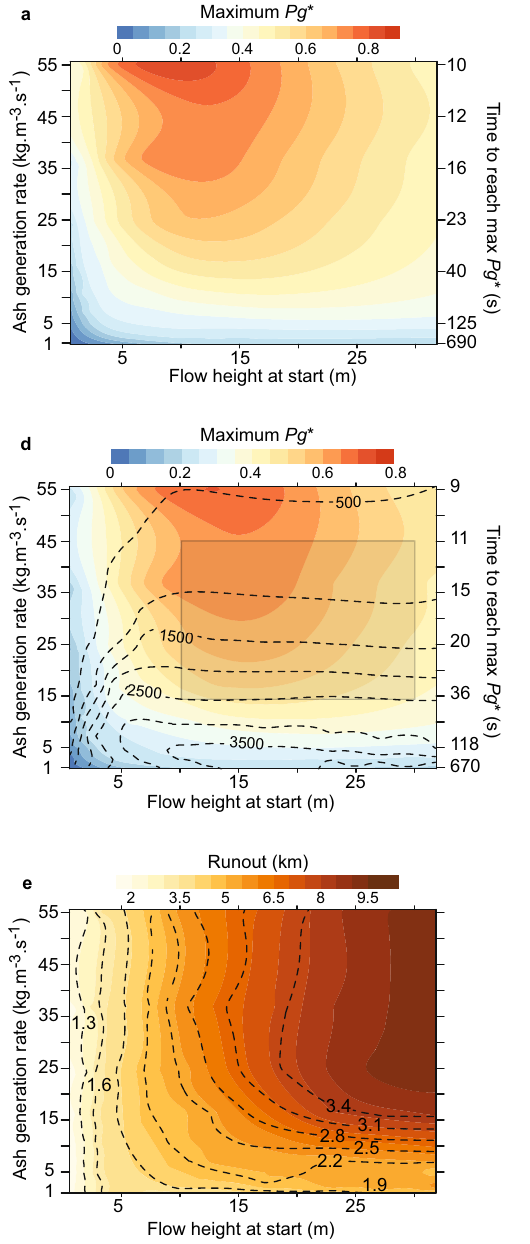
andscaledexcessporepressureareplottedwithdistance. d Similarto a butonthe Merapislopethusallowingsheartodevelop.Thedashedlinesareisocontourofthe distance at which the maximum excess pore pressure is reached. The grey box representstherangeofashproductionrateand fl owheightestimatedforthe2006 BAF at Merapi from the most proximal sample collected. e Runout of the mixture. The runout is scaled against the runout of the fl ow with same properties, but no fragmentationoccurs(noexcessporepressure).Isocontoursofthescaledrunouts are shown as dashed